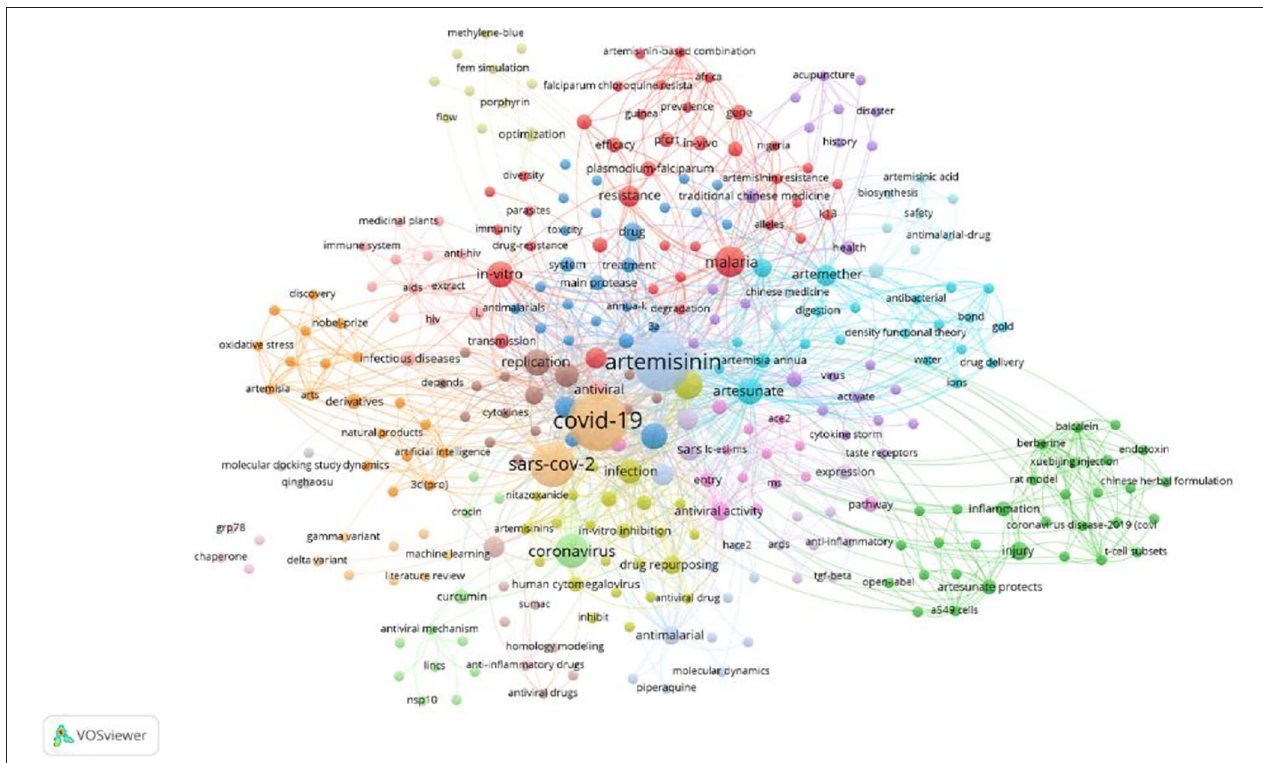
FIGURE 9 | The network on keywords of artemisinin treating coronavirus disease 2019